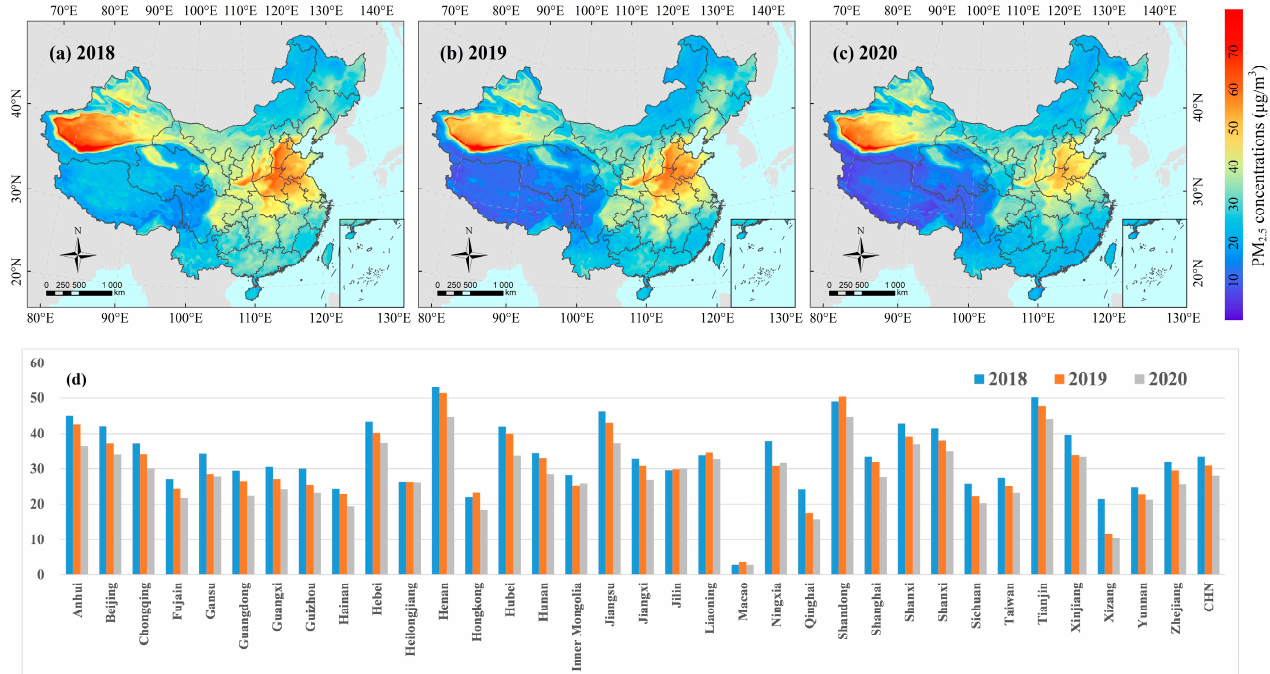
Figure 4. Spatial distribution ( a – c ) and regional numerical statistics ( d ) of annual mean estimated PM 2.5 concentration across China at 1 km resolution.